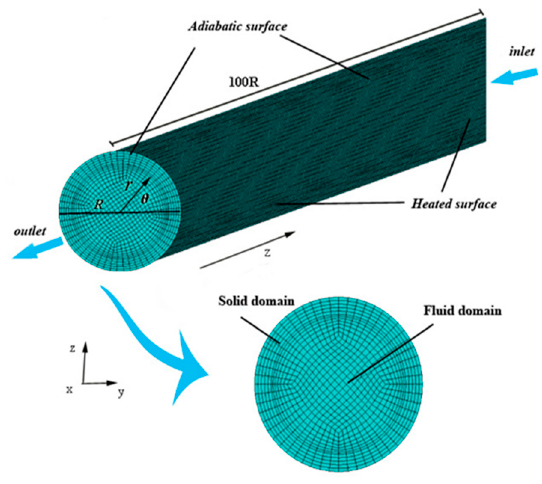
Figure 2. Schematic diagram of tower solar collector.